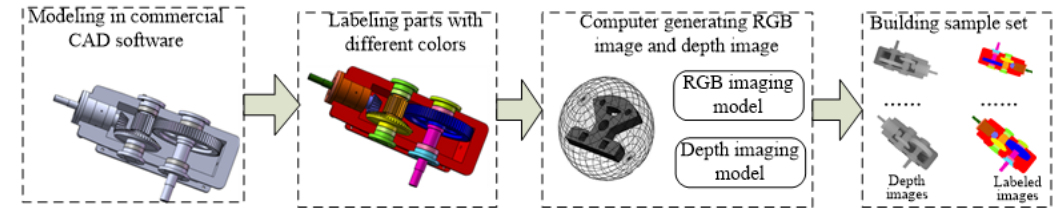
Figure 8. Flowchart of creating image segmentation data set.